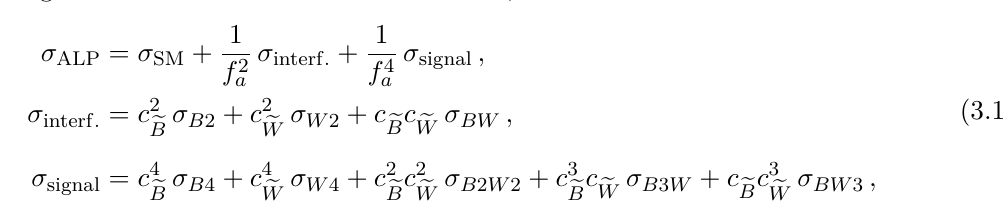
Table 1 . List of VBS processes considered in this work. For each, we indicate which terms in the polynomial dependence on c , c (eq. (3.1)) are present in the parameterization of the ALP signal. e W e B amplitudes that scale as f − 2 , and cross sections of order f − 4 . A generic VBS cross section, a a including both SM and EW ALP contributions, has the